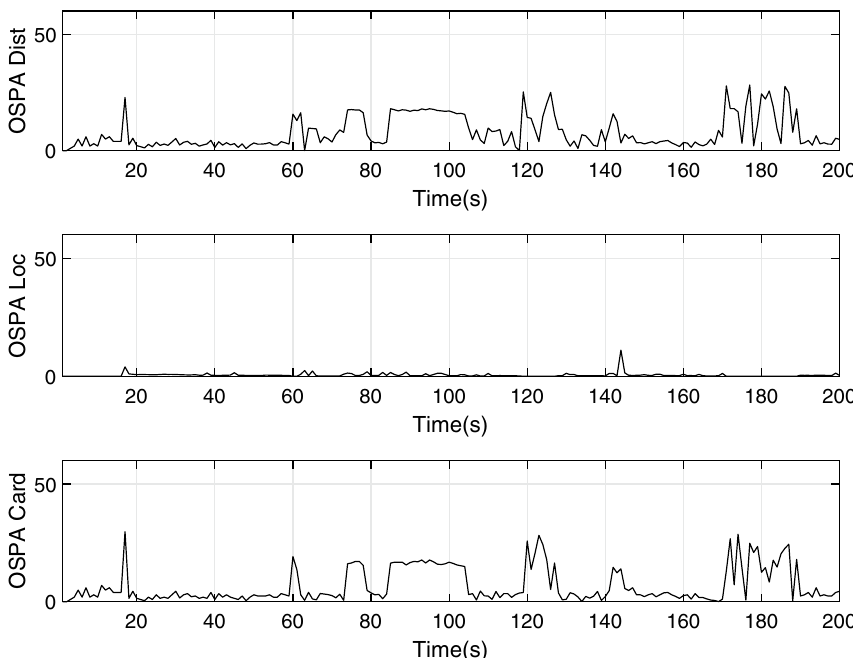
Fig. 12 The OSPA error (50MCs). Only considering the detected